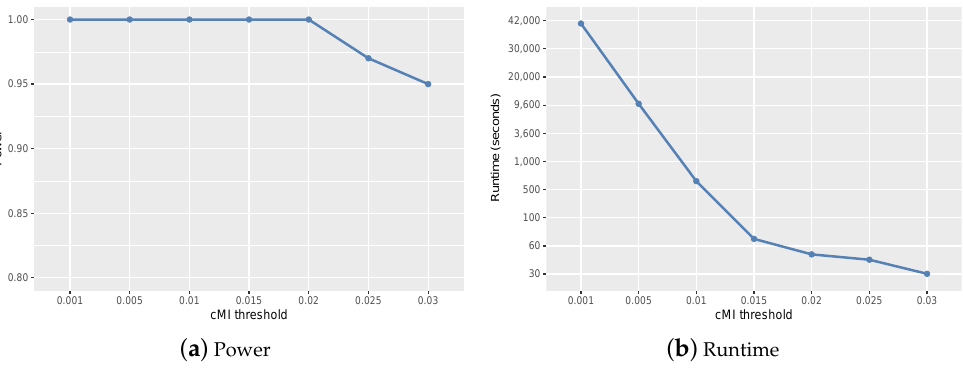
Figure 2. Power and runtime of ClusterMI under different cMI thresholds ( τ ) . ( a ) Power of ClusterMI for different τ ; ( b ) runtime of ClusterMI for different τ